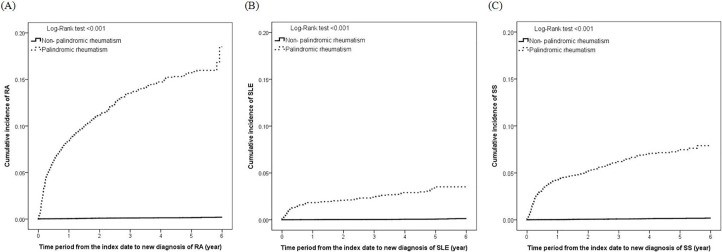
The cumulative incidences of RA (A), SLE (B), and SS (C) in the PR group and the non-PR group.